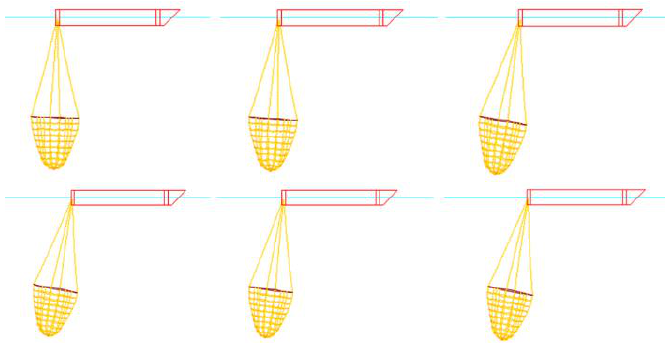
Figure 13. Shape changes of rigid truss trawl in straight-line towing at v = 1 m/s.